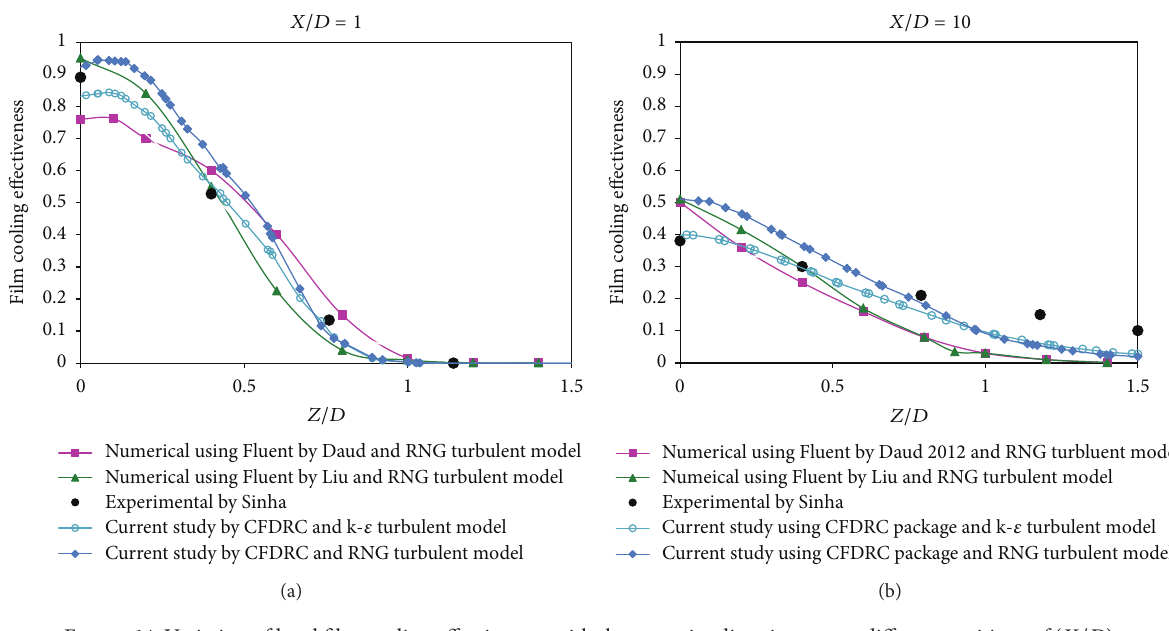
Figure 14: Variation of local film cooling effectiveness with the spanwise direction at two different positions of (𝑋/𝐷) .